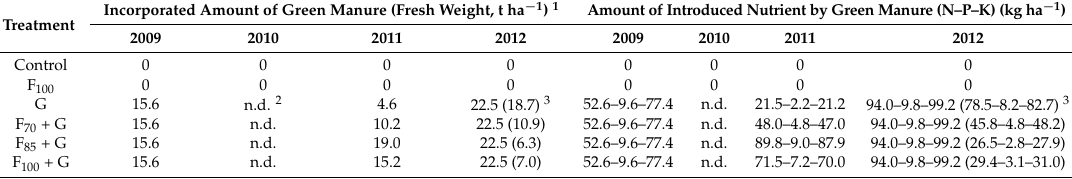
Table 2. Amounts of incorporated green manure and introduced nutrients for each treatment.